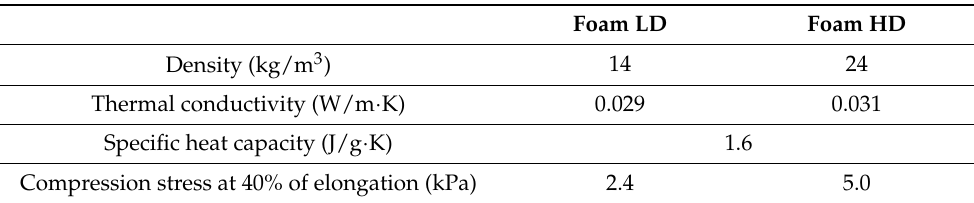
Table 1. Foam thermal